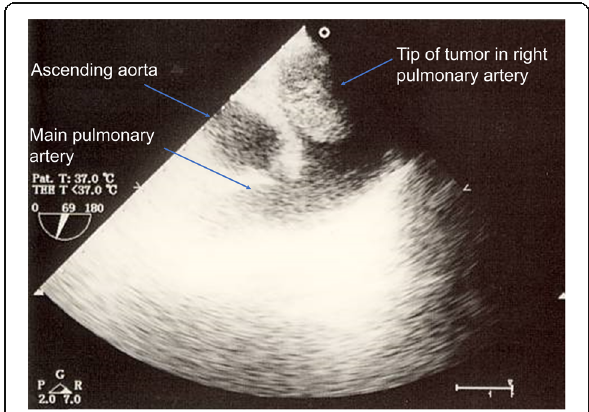
Fig. 2 The tumor in the pulmonary artery was confirmed on intraoperative transesophageal echocardiography. The transesophageal echocardiography revealed a mobile mass, extending from the left main pulmonary artery (PA) to the right PA, which obstructed the lumen of the right PA (as shown on the mid-esophageal aortic valve short-axis view)